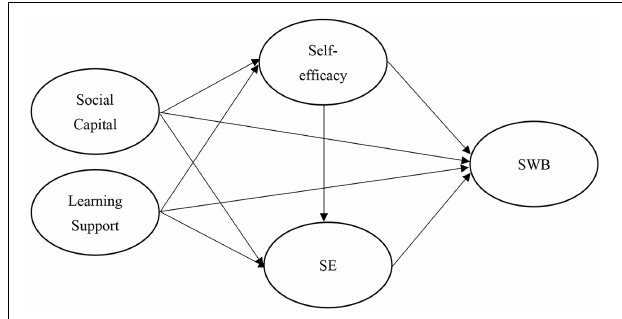
FIGURE 1 | Research